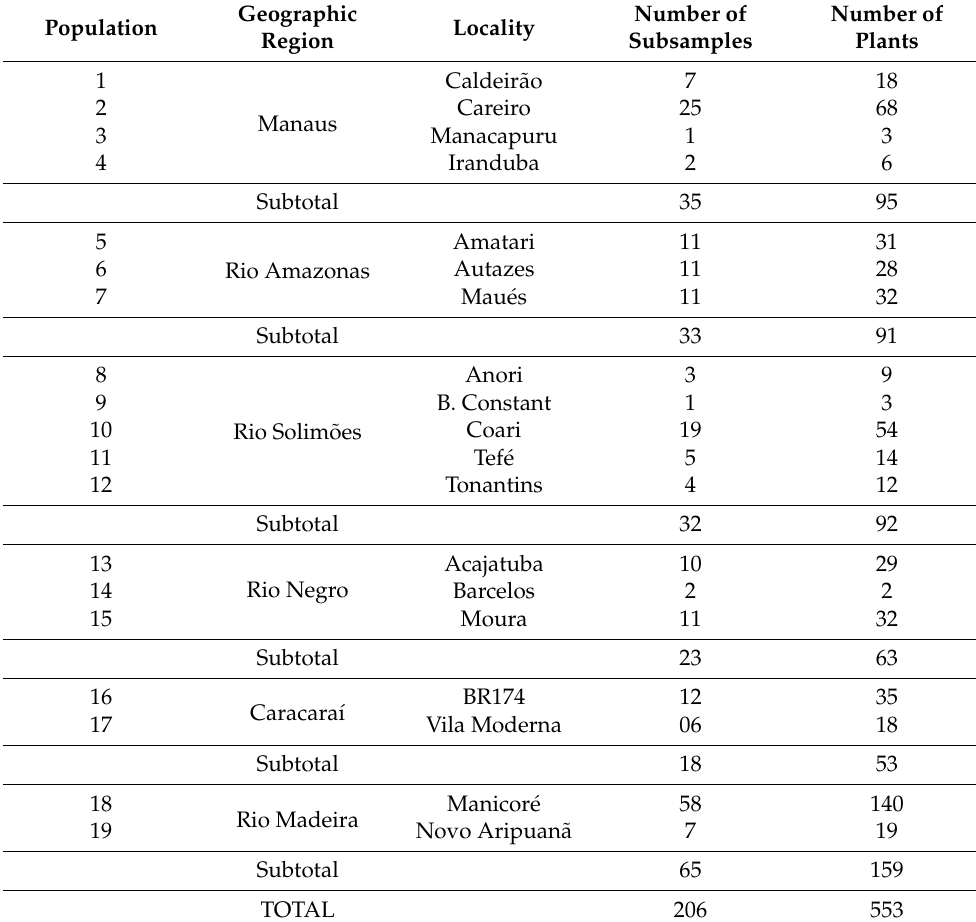
Table 1. Origin and number of 553 plants, representing 206 subsamples (half-sibling families) collected from the Elaeis oleifera Germplasm Bank at Embrapa Western Amazon (CPAA). Plants from 19 different populations (localities) originally collected at six distinct geographic regions in the Brazilian Amazon rainforest (Manaus, Rio Amazonas, Rio Solim õ es, Rio Negro, Caracara í e Rio Madeira). Number of Number of Geographic Locality Population Subsamples Plants Region 1 Caldeir ã Manaus